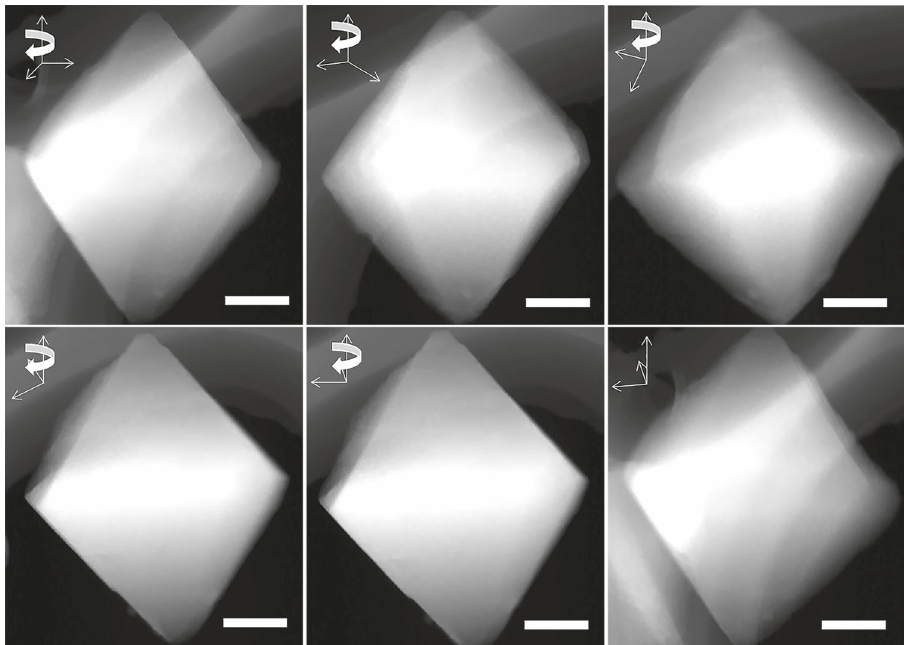
Fig. 2 HAADF-STEM images. The representative HAADF-STEM images captured from the video with a series of tilting angles for PtCu@MIL-101 sample taken with 2° tilt increment step from − 62.6° to 62.6°. Alpha tilt axis is parallel with Z direction shown on the images. The scale bar on the images is 100